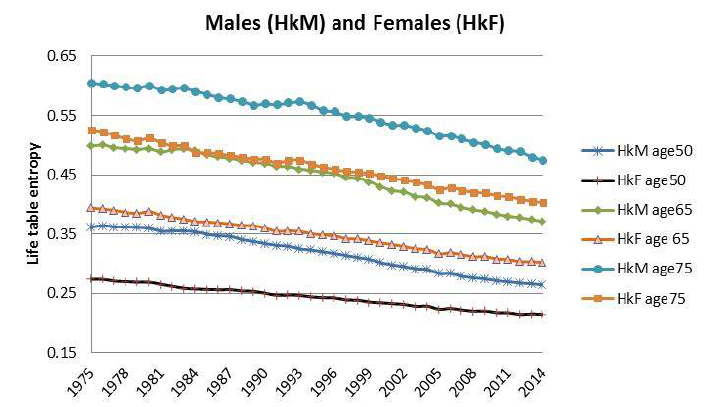
Figure 1. Italian life tables 1975–2014: males and females entropy ( t H K , ξ